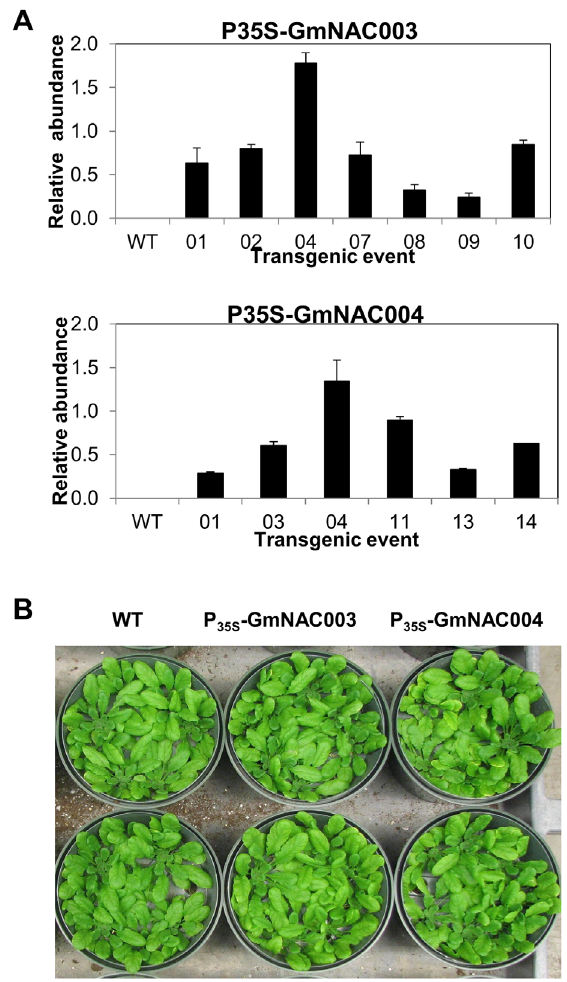
Figure 3. Transgenic Arabidopsis plants overexpressing soy- bean GmNAC003 and GmNAC004 . (A) Expression of the transgenes in 3-week-old transgenic plants quantified by qRT-PCR using Arabidopsis ubiquitin as the reference gene. The tissues were sampled from homozygous transgenic plants having a single insertion. Error bars are the standard errors of the means from three samples of ten plants. (B) Growth of the 4-week old and T4 generation GmNAC003 (events N3.09 and N3.10) and GmNAC004 transgenic (events N4.01 and N4.03) and WT plants.